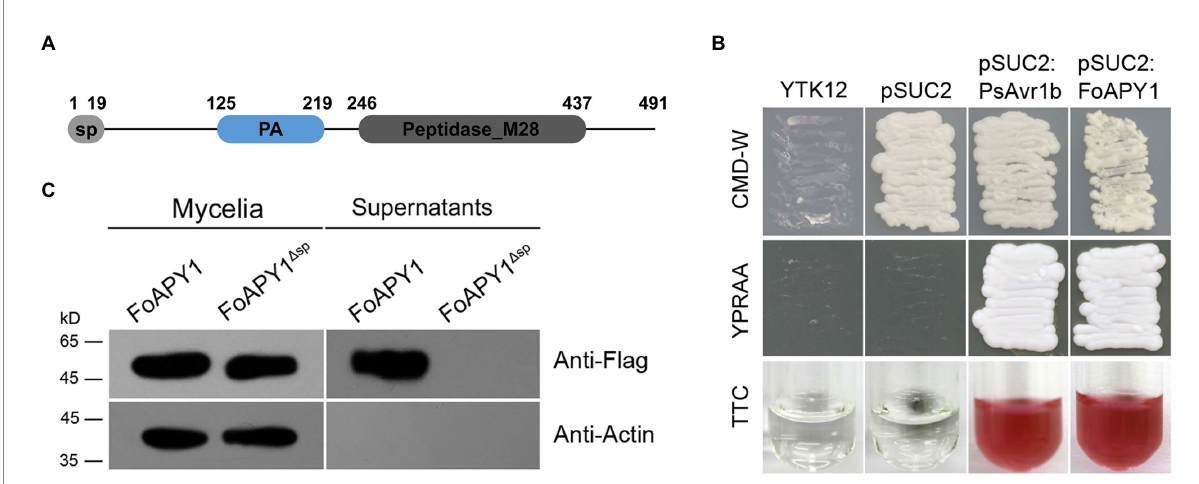
FIGURE 1 The FoAPY1 protein can be secreted from the F. oxysporum strain. (A) Diagram of the signal peptide (sp) and domains of the FoAPY1 protein. The sp. was predicted by 5.0 (https://services.healthtech.dtu.dk/service.php?SignalP-5.0) according to the FoAPY1 amino acid sequences. The domains of the FoAPY1 protein were analyzed by the online SMART program (http://smart.embl-heidelberg.de/). (B) Secretion functional validation of the predicted sp. of FoAPY1 using a yeast invertase experiment. All the obtained transformed yeast strains were cultured on CMD-W media. YPRAA media were used to verify the yeast invertase-enabled secretion of invertase containing the target sp. sequences in the pSUC2 vector. The YTK12 strain could not grow on CMD-W and YPRAA media due to untransformation of the pSUC2 vector. The change in colour of TTC was used to test the enzymatic activity. The sp. of PsAvr1b from Phytophthora sojae was used as a positive control. (C) The FoAPY1-Falg and FoAPY1 ∆ sp -Falg strains were used for the in vitro secretion assay. The conidia of the two strains were cultured in 10% YEPD media and induced with tomato roots. All the proteins in culture supernatants were collected and then analyzed by western blotting in conjunction with anti-Flag (upper panel) and anti-actin (lower panel)